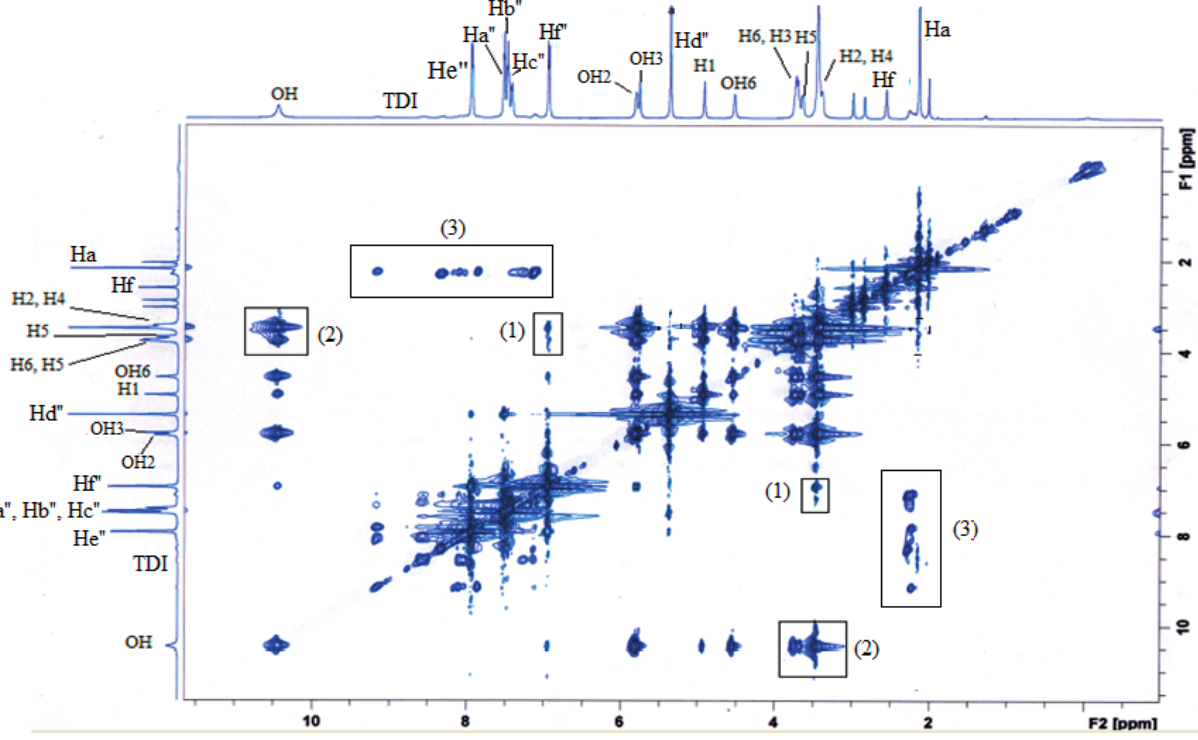
Figure 11. 2D NOESY spectrum of MAA- β -CD-BzP inclusion complex; (1) cross peaks of protons Hf'' of BzP with H3 and H5 of β -CD; (2) cross peaks of protons OH of BzP with H3 and H5 of β -CD; (3) cross peaks of protons Ha of MAA and BzP,